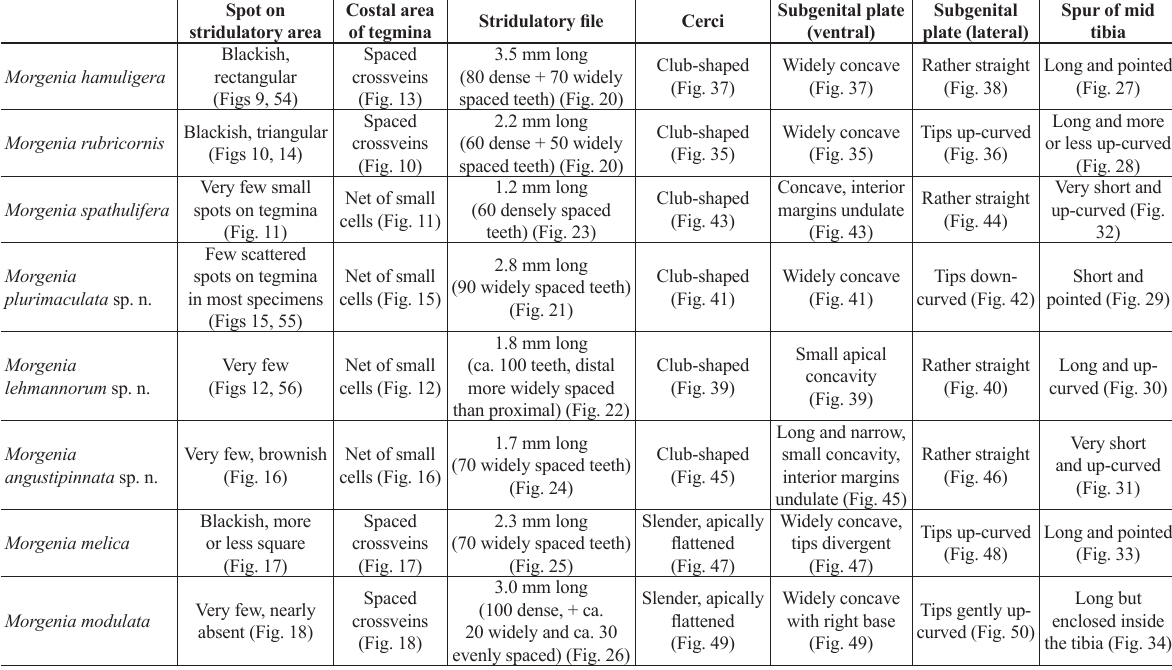
Table 2. Main characters that allow the separation of males of the eight species of the genus Morgenia